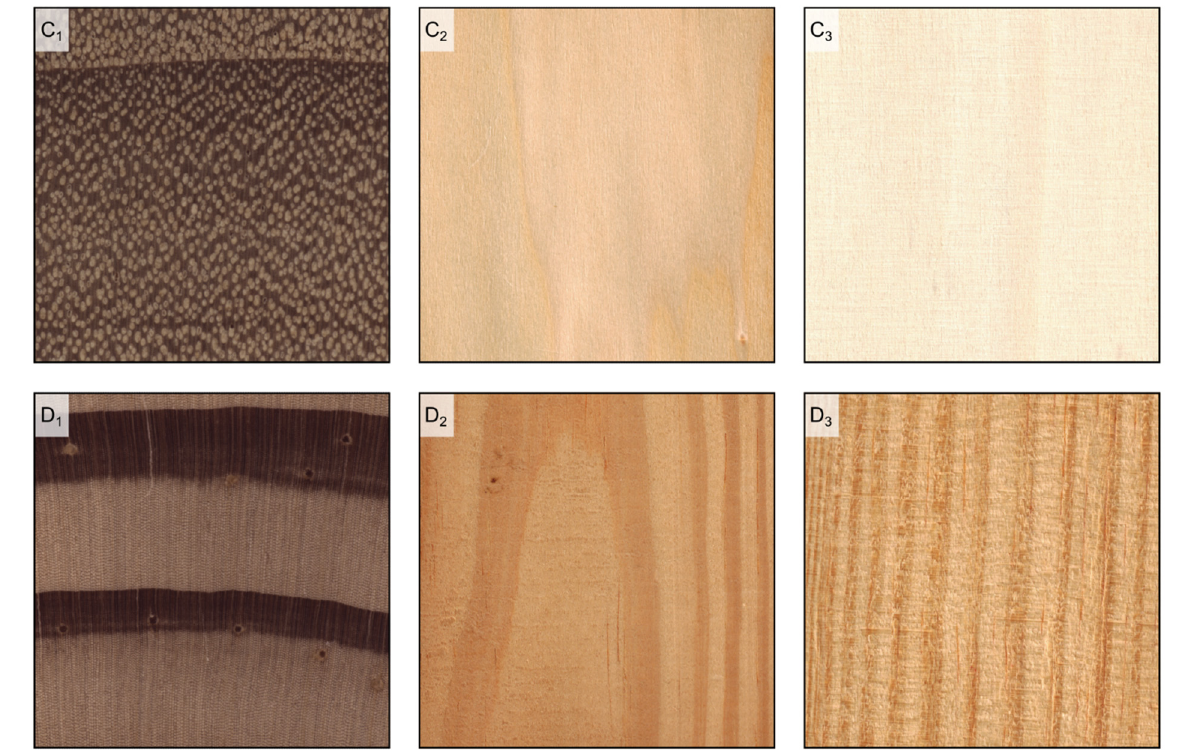
Figure 10. Rays’ visibility to the naked eye. In Quercus petraea , some of the rays are clearly more evident than the others on the transverse surface (( A 1 ) transverse section), are visible on the tangential surface and over 5 mm high (( A 2 ) longitudinal tangential surface), and visible on the radial surface (( A 3 ) longitudinal radial surface); in Platanus occidentalis , rays are visible on the transverse surface and noded (( B 1 ) transverse section), they are visible on the tangential surface and less than 5 mm high (( B 2 ) longitudinal tangential surface), and visible on the radial surface (( B 3 ) longitudinal radial surface); in Populus tremula , rays are not visible on either the transverse surface (( C 1 ) transverse section) and the tangential surface (( C 2 ) longitudinal tangential surface), while barely noticeable on the radial surface (( C 3 ) longitudinal radial surface); in Pinus sylvestris , rays are not visible on either the transverse surface (( D 1 ) transverse surface) and the tangential surface (( D 2 ) tangential surface), while barely noticeable on the radial surface (( D 3 ) longitudinal radial surface).